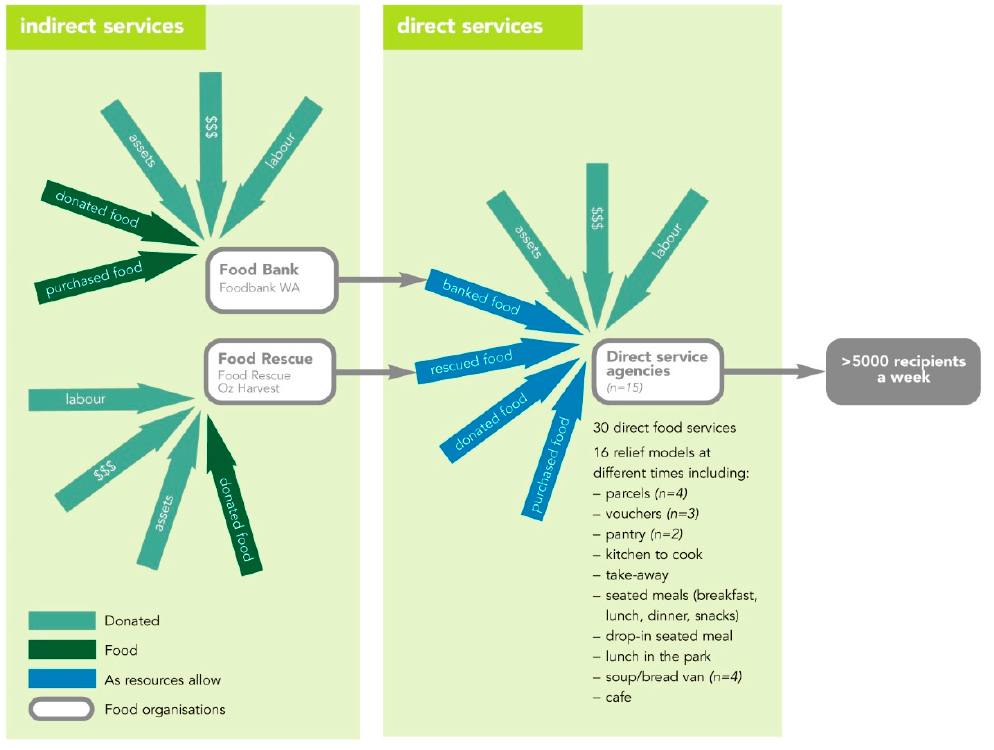
Figure 1. Model of the charitable food sector in inner-city Perth.